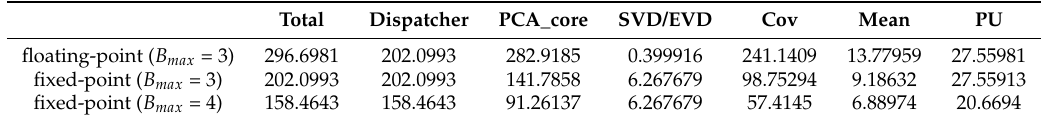
Table 2. Latency (ms) for Zedboard, HI data set, bands = 12.